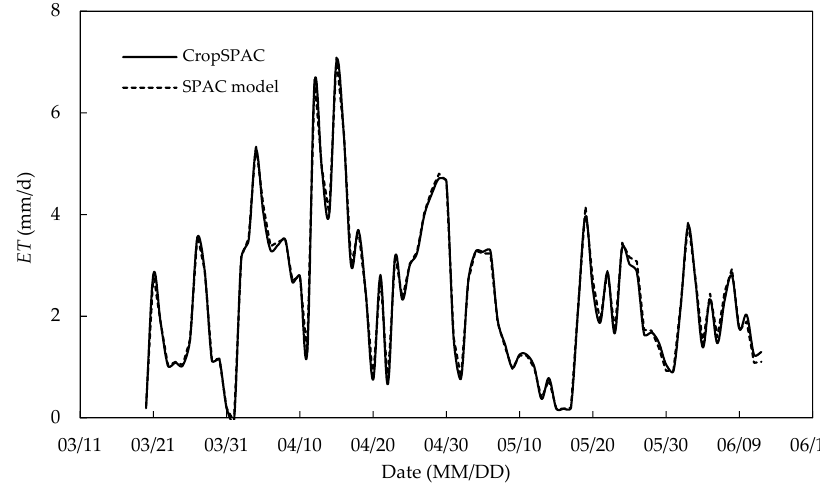
Figure 17. Comparison between CropSPAC and SPAC model simulated daily ET (mm).